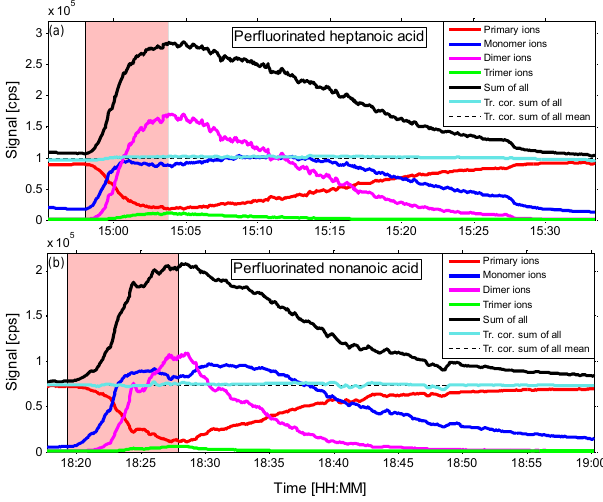
Figure 4. Measurement examples for (a) perfluorinated hep- tanoic acid and (b) perfluorinated nonanoic acid. Data are slightly smoothed (moving average). Heating (indicated by red shaded ar- eas) leads to increased evaporation of the perfluorinated acids and a depletion of primary ions. After the heating period the system cooled down to room temperature, with the corresponding decrease in signal for perfluorinated acids and recovery of the primary ions. The sum of all signals shows a clear increase due to the heating pe- riods, as charge is shifted to higher m / z regions. As the amount of charge is limited by the primary ions, this indicates that a higher fraction of ions reaches the detector when the ions are at the m/z range of the monomer or dimer of pentanoic or nonanoic acid. This is direct evidence for higher transmission efficiencies at these m/z